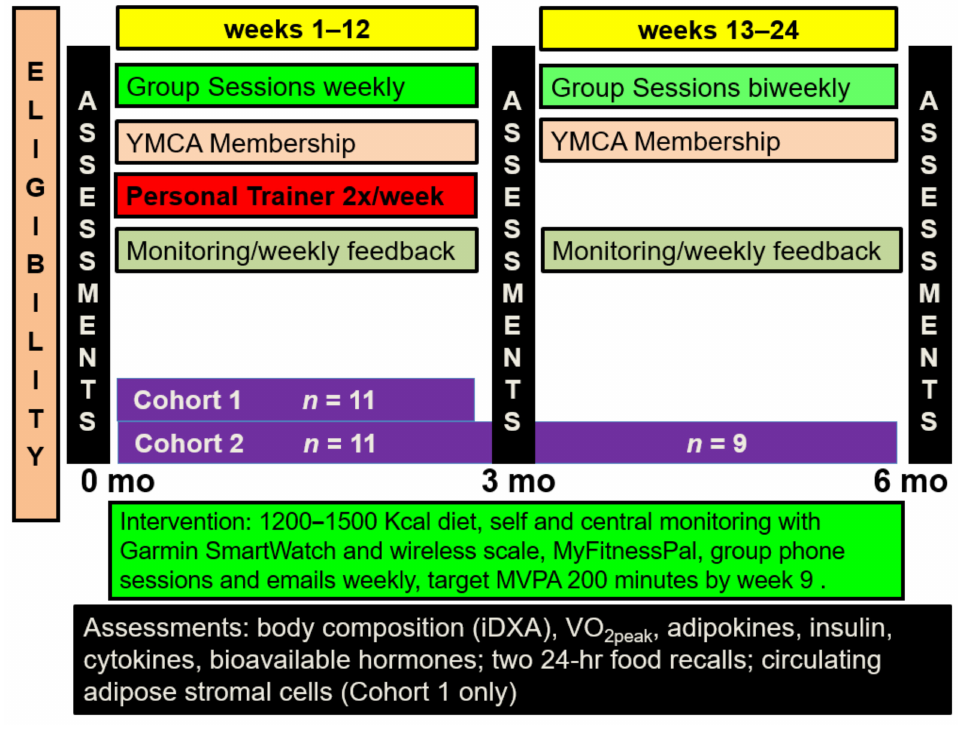
Figure 1. Diet and exercise interventional design for the two